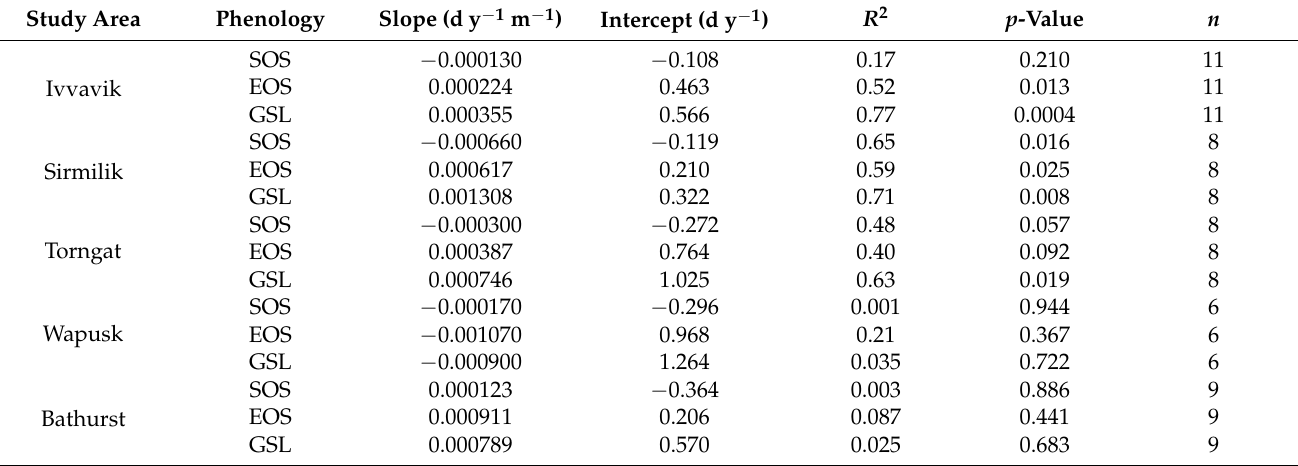
Table 4. Statistics for the relationships between phenology trend during 1985–2013 and elevation over the five study areas. Study